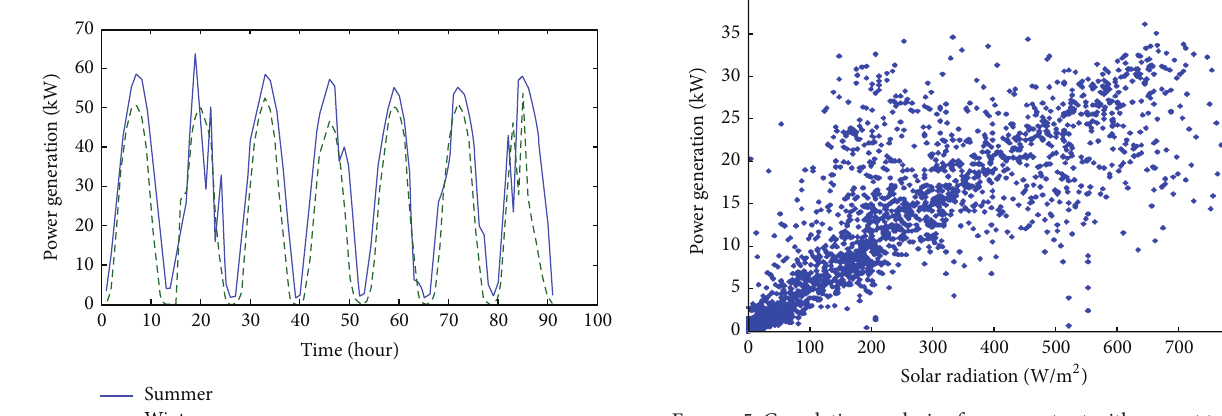
Figure 5: Correlation analysis of power output with respect to solar irradiance at the PTM Green Energy Office